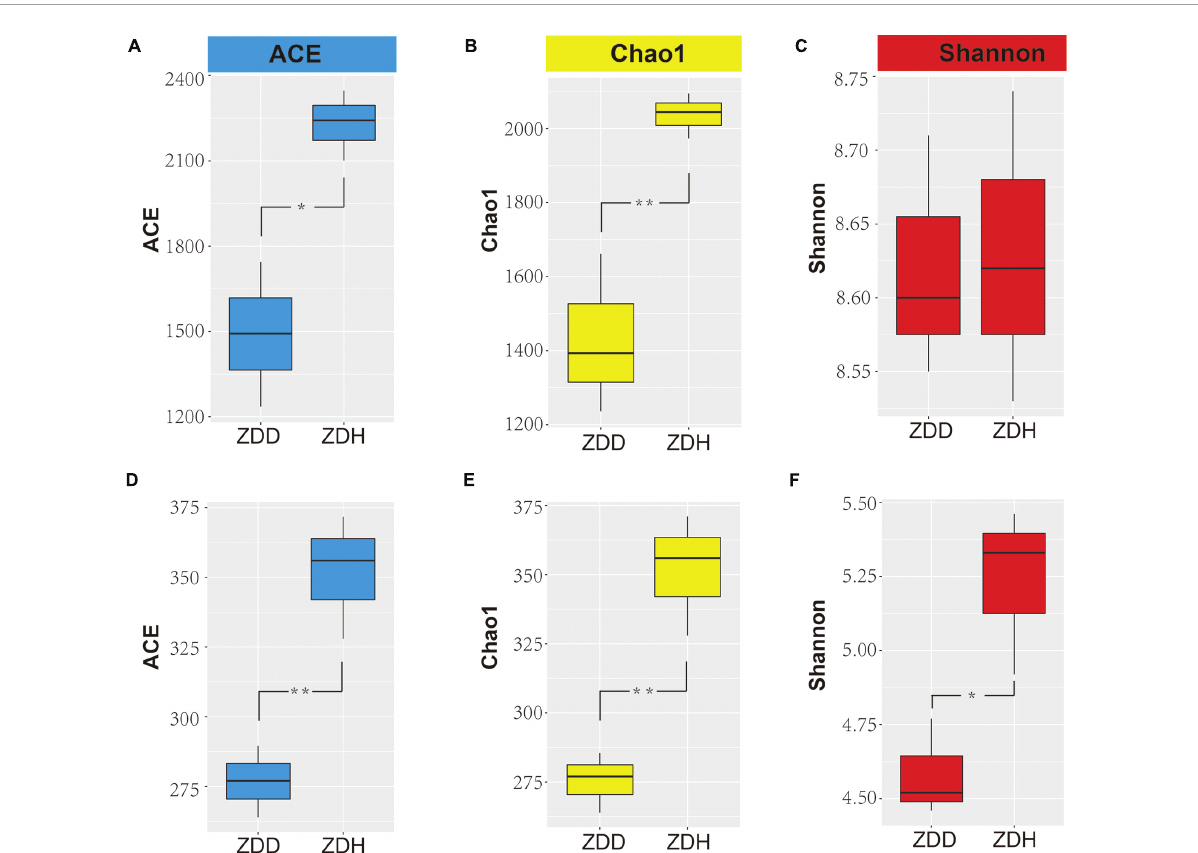
FIGURE1 Differences in bacterial (A–C) and fungi (D–F) alpha diversity indices in maize rhizosphere soil. Panels (A,D) were ACE diversity indices, panels (B,E) were Chao diversity indices, and panels (C,F) were Shannon diversity indices. ZDD refers to rhizosphere soil with severe stalk rot disease, and ZDH refers to the rhizosphere soil with disease-free near by the